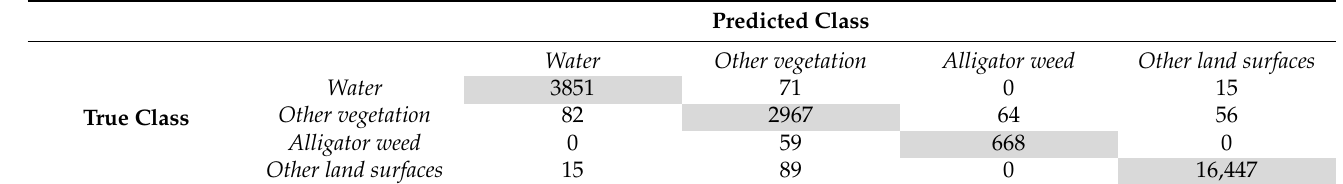
Table 8. Confusion matrix for the 2016 random forest classifier (pixel count from the validation dataset, the grey areas means correctly identified